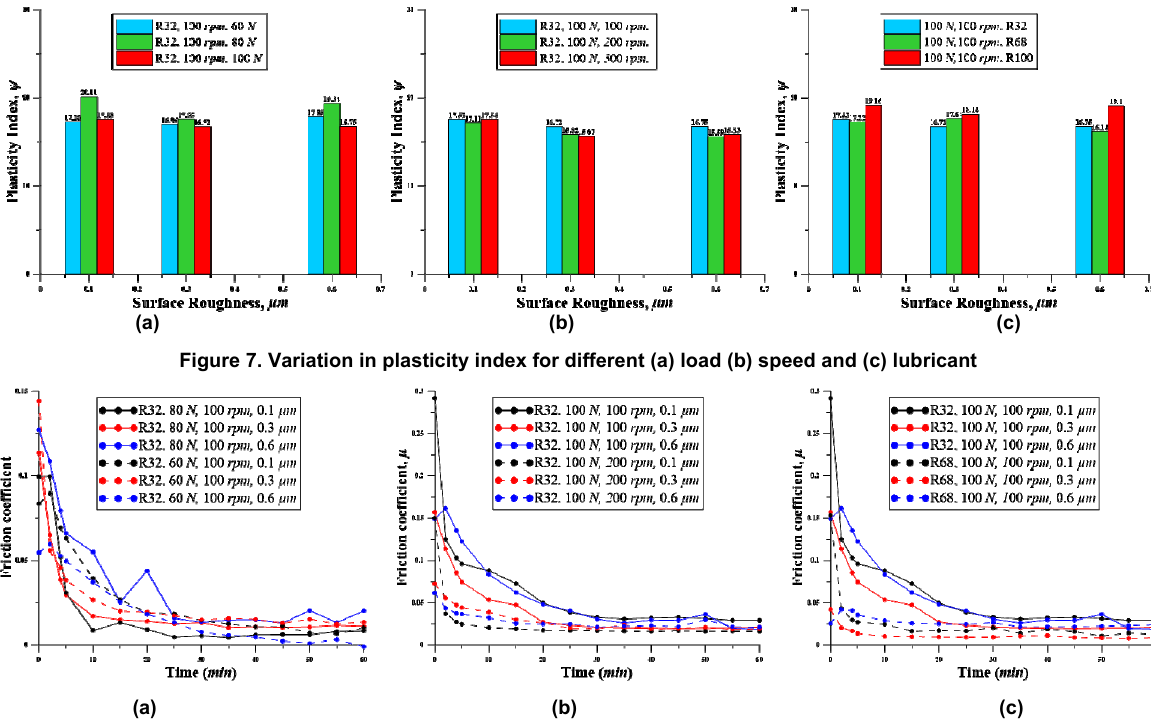
Figure 8. Variation in friction coefficient during running-in for ditterent (a) load (b) speed and (c) lubricant